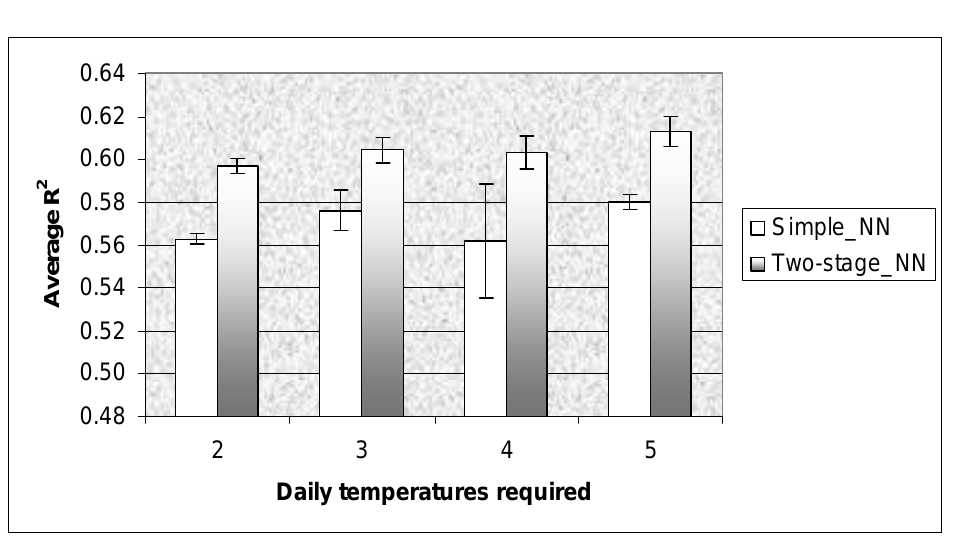
Figure 2. Ability of simple and 2-stage NN models to predict remaining shelf life (RSL) of living lettuce where model inputs include the current average daily temperature t ( c ) plus one to four average daily temperatures from 1, 2, 3 or 4 days prior to the current day. For example, “daily temperatures required” of 2 included t ( c ) and t ( c -1), and the value 5 included t ( c ), t ( c -1), t ( c -2), t ( c -3), and t ( c -4). Good fit was indicated by higher R 2 in 2- stage NN (R 2 =0.61) compared to simple NN (R 2 =0.57) with LSD=0.016, according to the Proc GLM of SAS software package (SAS 9.1.3). Each bar represents a mean and its standard error obtained with testing of randomly selected testing data set. Each bar represents the mean of 2 to 4